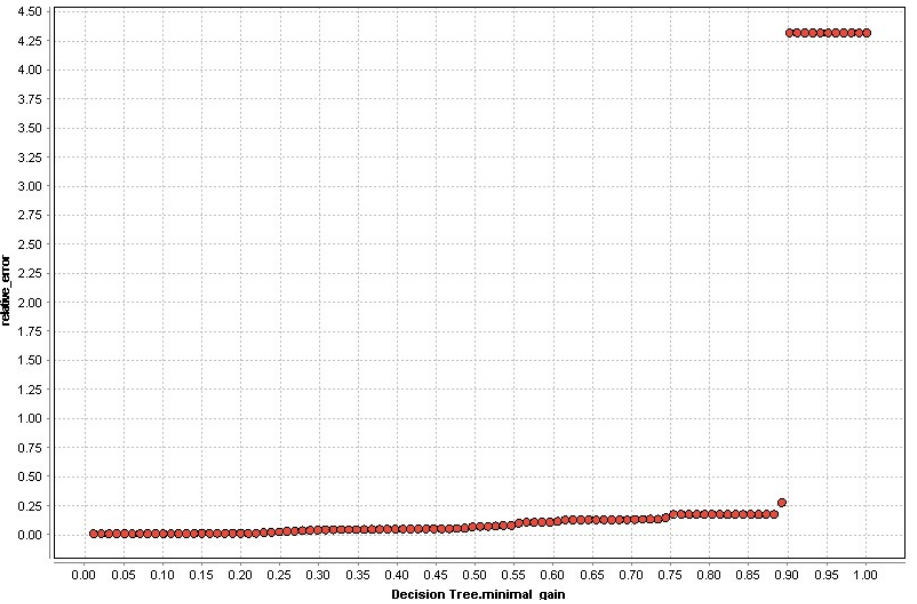
Figure 10. Minimal gain tuning results for Random Forest model.